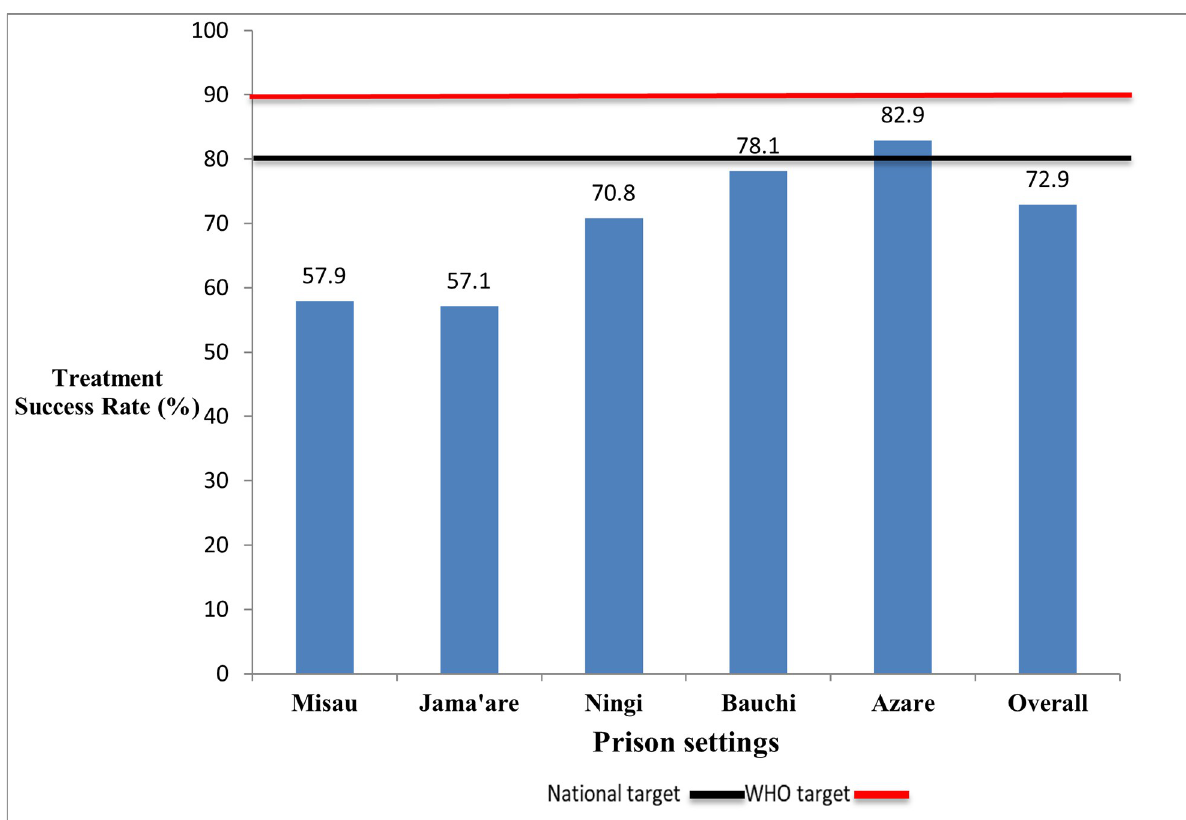
Fig 2. Treatment success rates of TB patients in the five main prison settings in Bauchi State from January 2014 to December 2018.